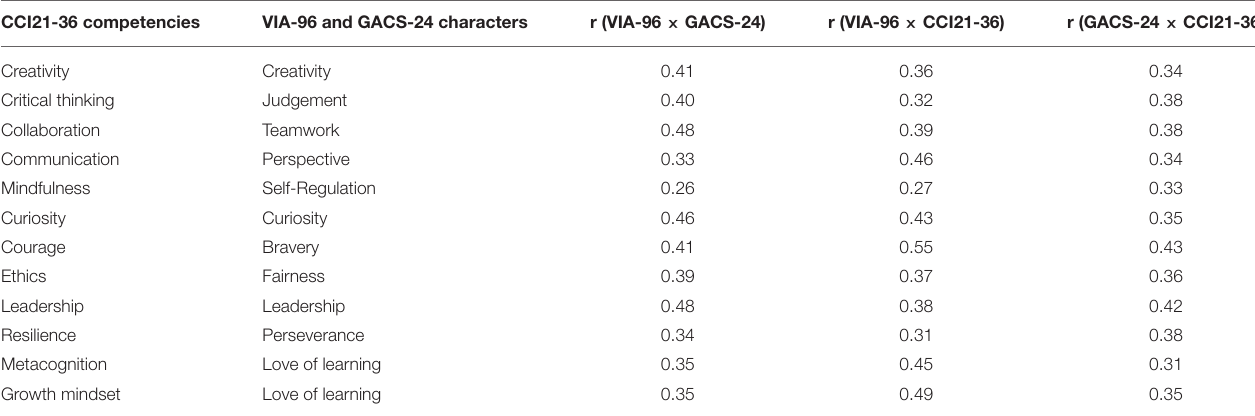
TABLE 8 | Comparative table of final correlation scores between VIA-96 and GACS-24 characters, VIA-96 characters and CCI21-36 competencies, and GACS-24 characters and CCI21-36 competencies. CCI21-36